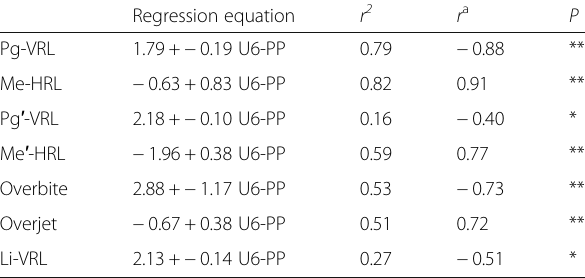
Table 4 Regression between upper molar intrusion and selected